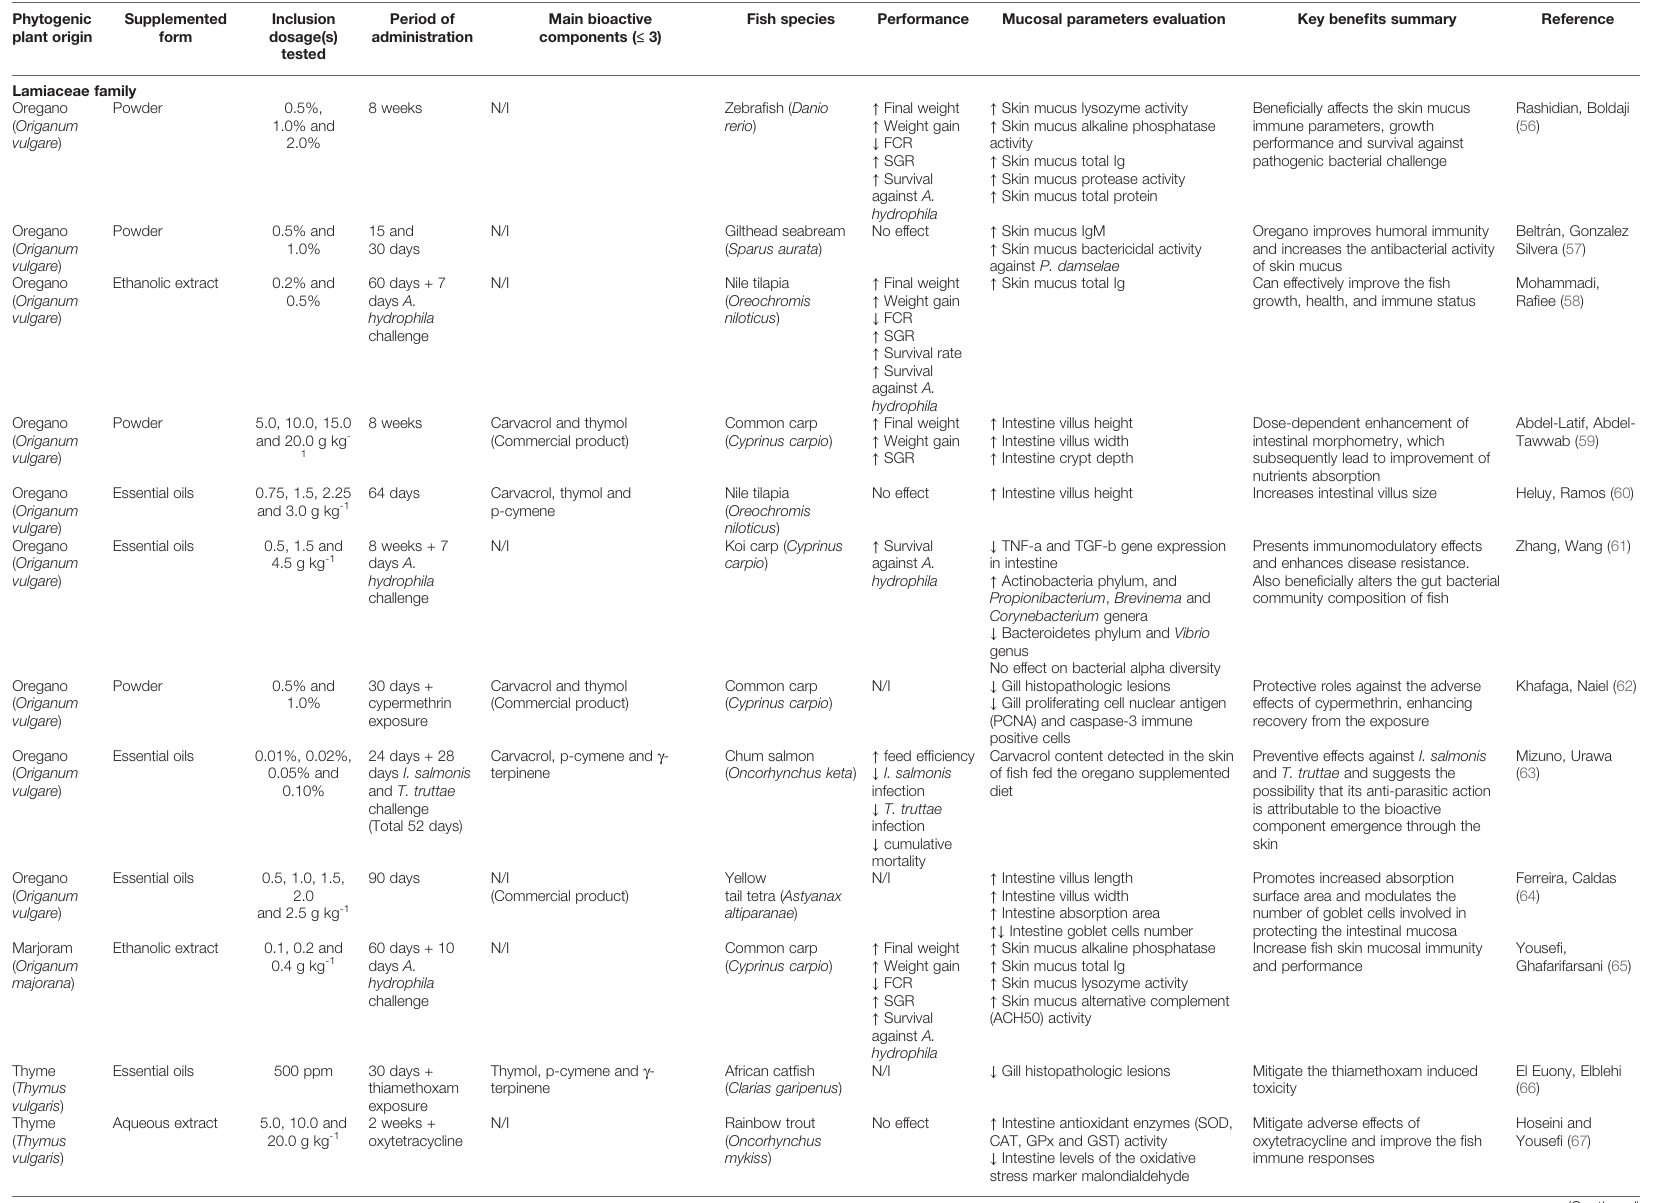
TABLE 1 | Extended summary of the current available literature on nutritional effects of Lamiaceae family and Allium sp. derived phytogenics upon fi sh mucosal immune